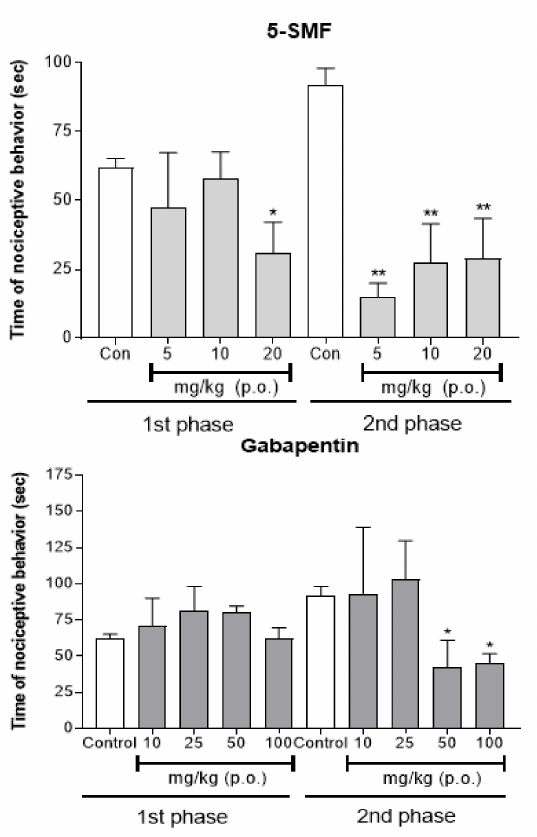
Figure 14. Effect of 5-SMF and gabapentin in the formalin test in mice. Data are expressed as mean ± SD; n = 4 mice per group. (* p < 0.01, ** p < 0.001 vs. control